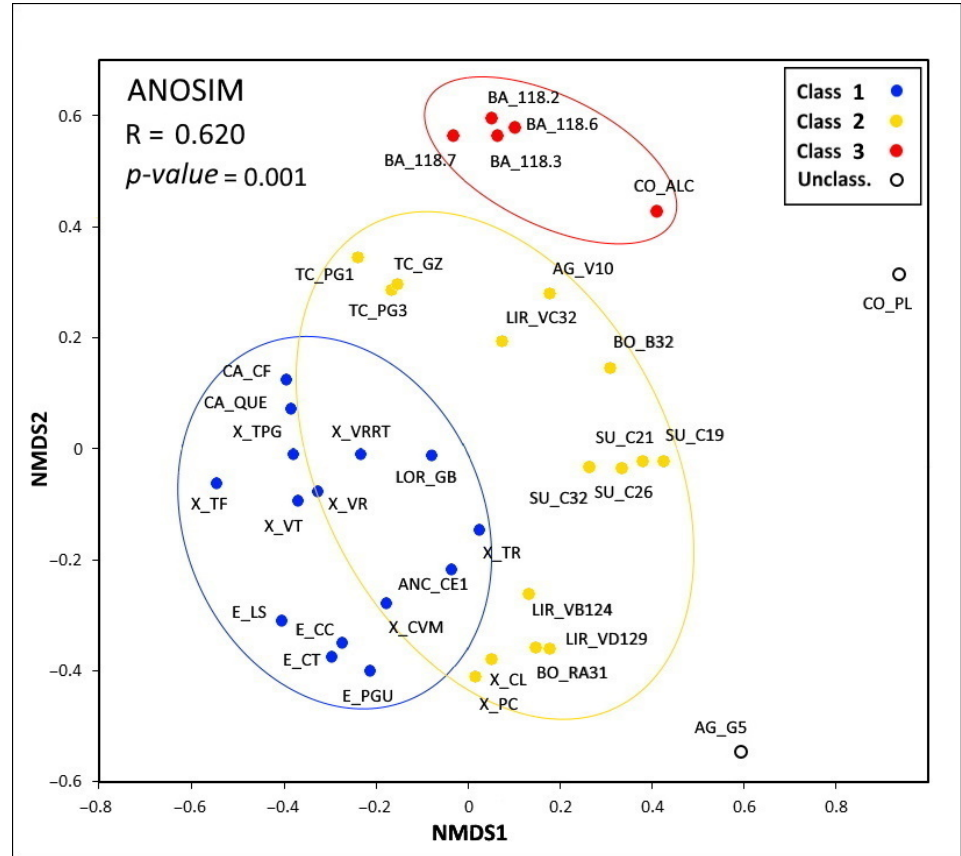
Figure 2. Non-metric multidimensional scaling (NMDS) of the testate amoeba communities in the thirty-seven western Iberian peatlands shows three significant classes: class 1 (Xistral, A Capelada, Ancares, Gándaras de Budiño), class 2 (Xistral (blanket bogs), Terra Chá, Bocelo, Suído, Limia river valley, A Groba), class 3 (Barbanza, CO_ALC), and Unclassified (AG_G5, CO_PL).